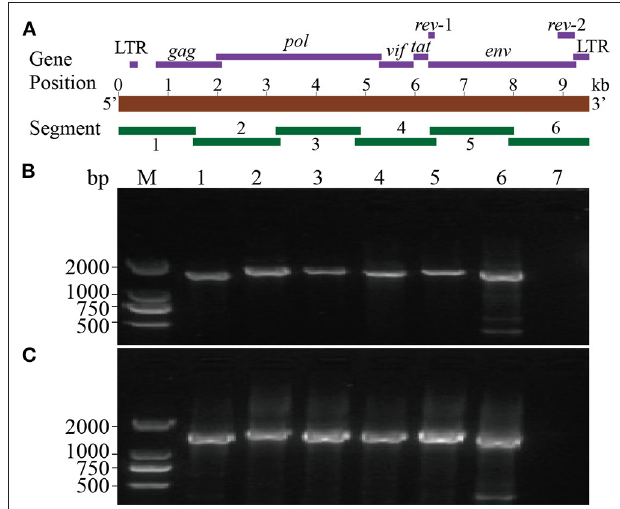
FIGURE 3 | Whole-genome amplification of Chinese Visna/Maedi virus strains. (A) Schematic diagram of the VMV genome. Purple bands indicate the position of encoded genes. Red band indicates the length of VMV genome. Green bands indicate the position of six amplified segments. (B)